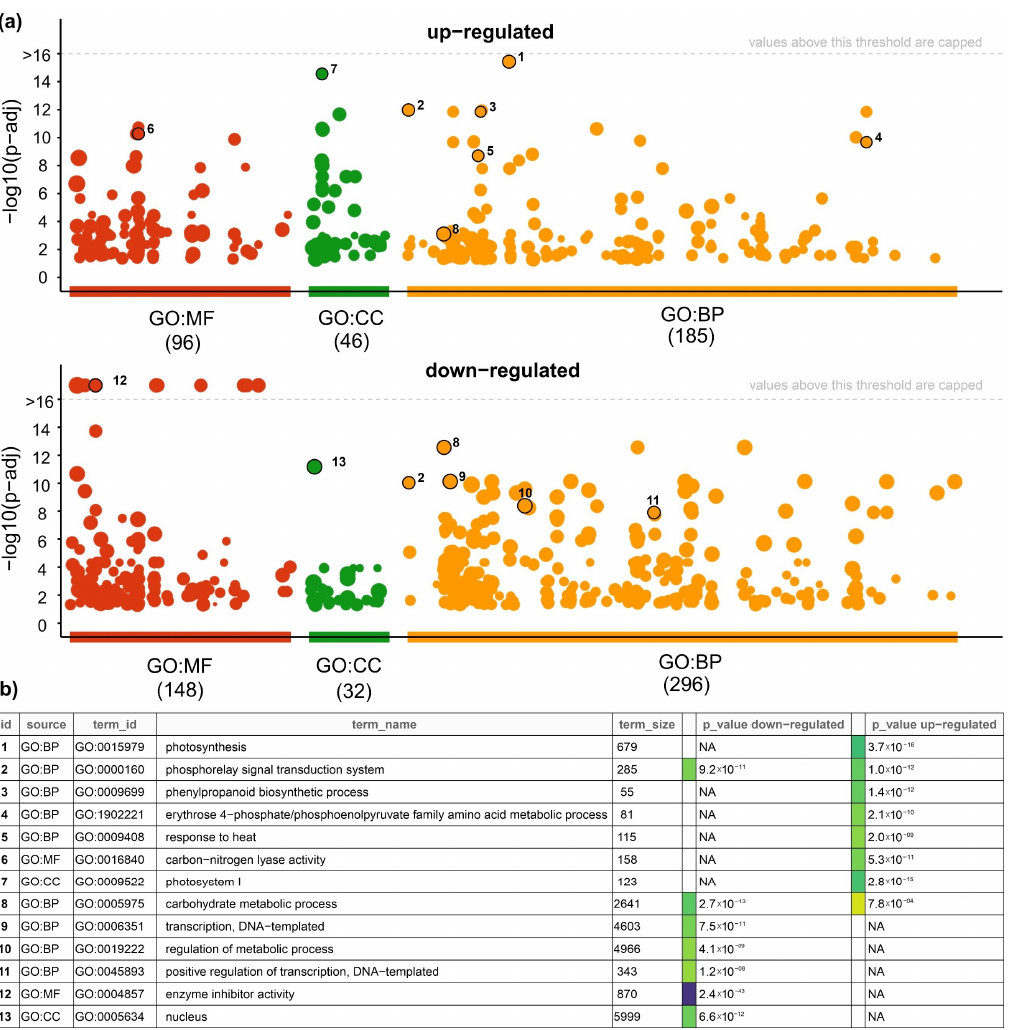
Figure 5. Gene ontology (GO) enrichment of differentially expressed genes (DEGs) based on tran- scriptomic data from short heat stress in durum grain wheat. ( a ) GO analysis of DEGs associated with a molecular function (MF) in red, cellular component (CC) in green, and biological process (BP) in orange. The upper panel represents the upregulated genes and the lower panel the downregu- lated genes. The numbers in parentheses denote the total numbers of GO terms for each category. ( b ) Table with a ranking of the five most significantly enriched biological processes for down- and upregulated genes. In addition, the most enriched GO term of the MF and CC domain is also indi- cated. The dot labels with a number (1 to 13) in ( a ) are described in ( b ). Each circle in the Manhattan plot represents a significant GO term (adjusted p -value < 0.05) using gprofiler2 software [51], and colors indicate the GO domain (MF: molecular function, CC: cellular component, BP: biological pro- cess).